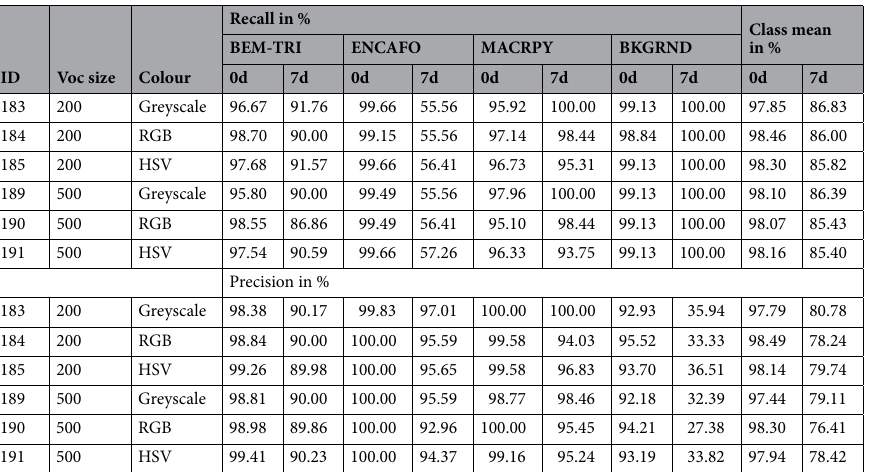
Table 3. Reduction to four categories by pooling for training and testing (TestSet of Lab0d and Lab7d). BEM- TRI is the pooled class of B. tabaci and T. vaporariorum.